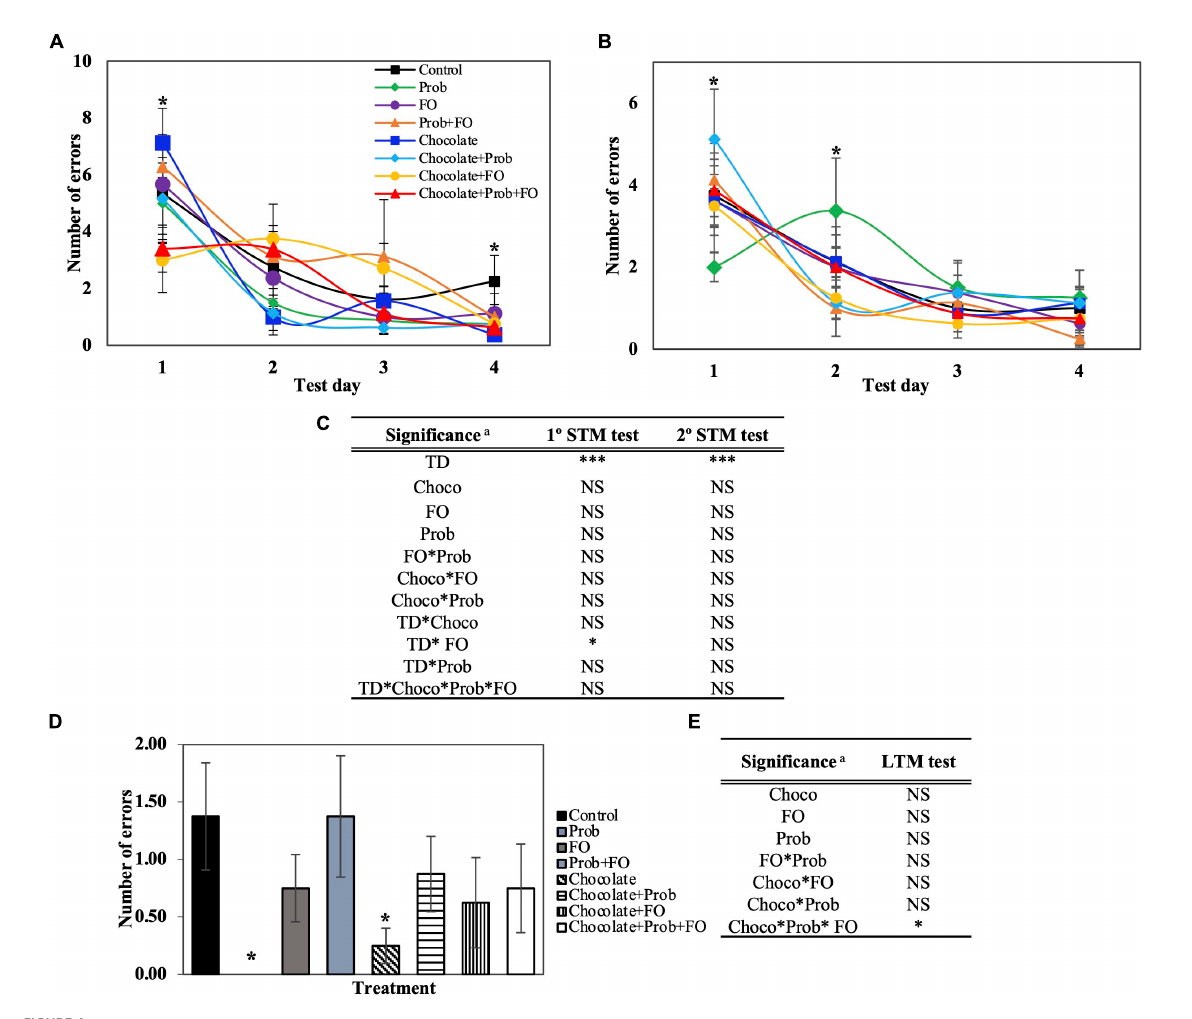
FIGURE4 Total number of errors using the Barnes Maze test. STM, short-term memory; LTM, long-term memory; TD, test days; Choco, chocolate; FO, fish oil; Prob, probiotics; NS, non-significant. a Asterisks (*) indicate significant difference LSD test: * p < 0.05, *** p < 0.001. (A) First session of STM test, (B) Second session of STM test (after 45 min), (C) Significance of treatments interactions and test days on the first and second STM test, (D) LTM test (7th day), (E) Significance of treatment interactions and test days on the LTM test. Values are means, and bars indicate the standard error of the